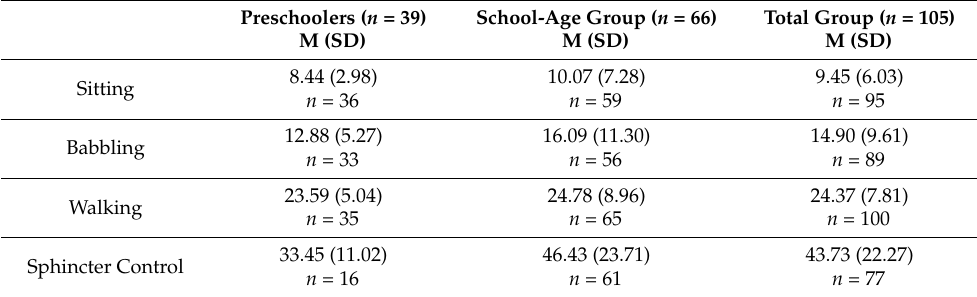
Table 2. Descriptive statistics of age of acquisition (in months) of developmental milestones.